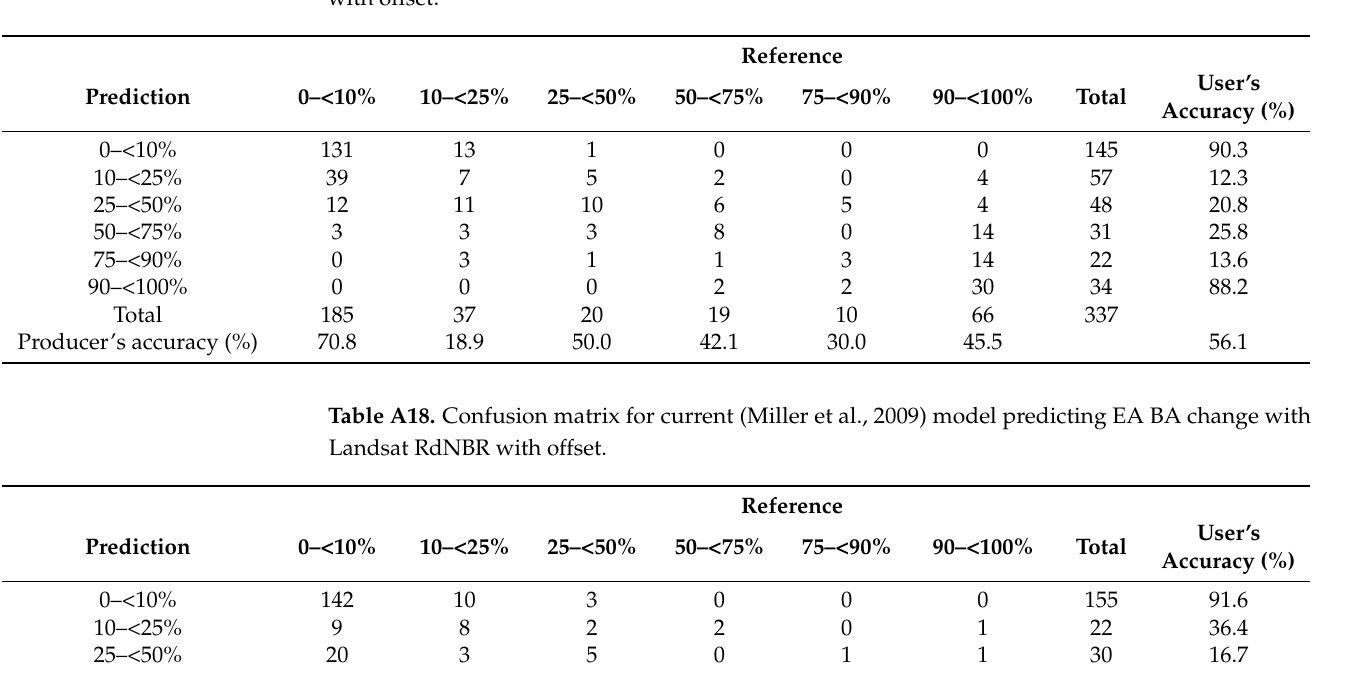
Table A17. Confusion matrix for Southwest model predicting EA BA change with Sentinel-2 RBR with offset.